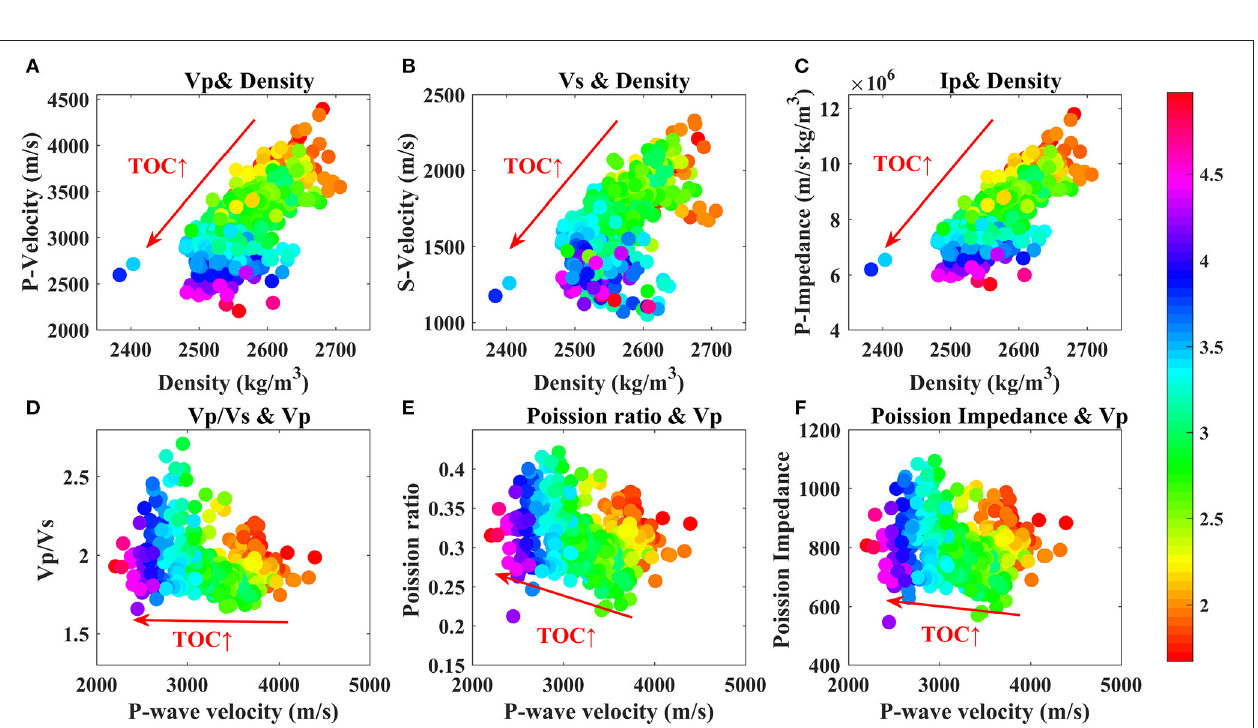
FIGURE 9 | Crossplot of elastic parameters versus TOC content using actual well L2 data. (A) V p and ρ , (B) V s and ρ , (C) I p and ρ , (D) V p / V s and V p , (E) Poisson’s ratio and V p , (F) Poisson impedance and V p . The color bar on the right represents the TOC content.